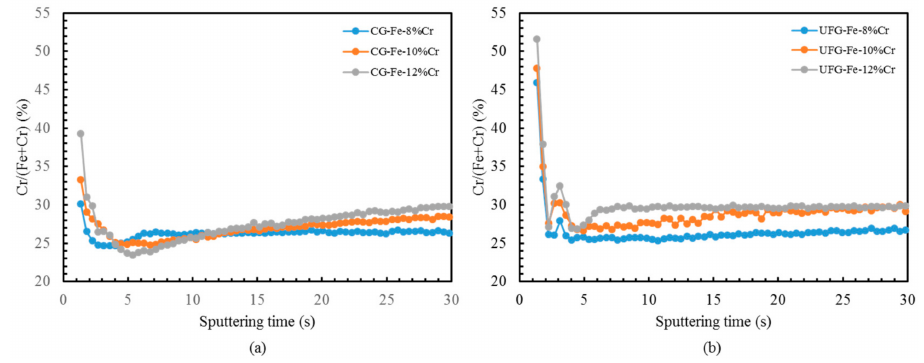
Figure 6. Cr/(Fe + Cr) ratio as determined by GD-OES as a function of sputtering time for ( a ) CG and ( b ) UFG alloys prepared by